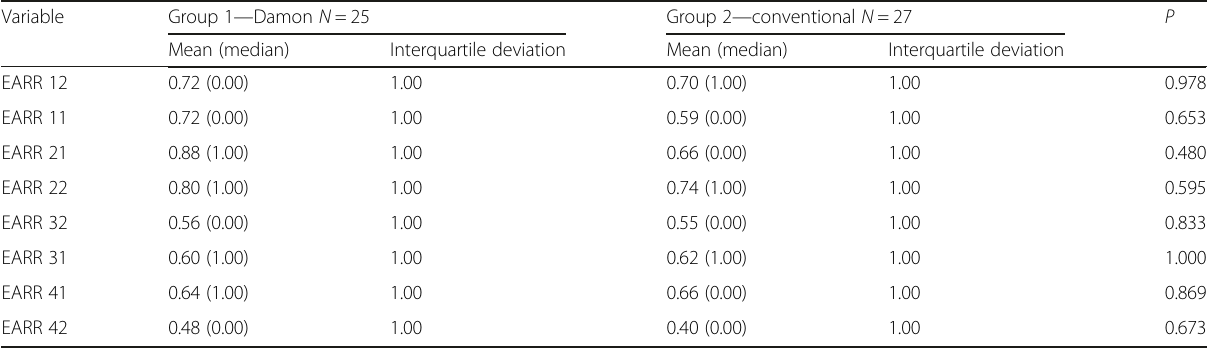
Table 2 Intergroup comparison of the amount of root resorption at the end of treatment (Mann-Whitney tests) Variable